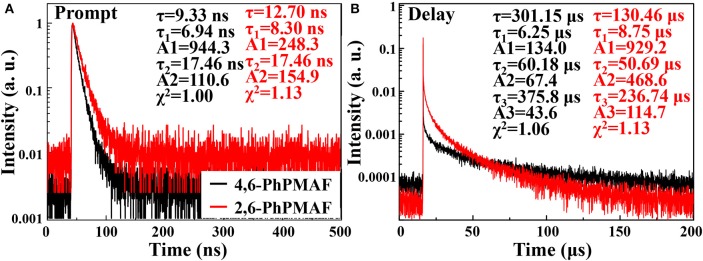
Transient photoluminescence characteristics of (A) prompt and (B) delay of 4,6-PhPMAF and 2,6-PhPMAF dopants in degassed CH2Cl2 solution and 22 wt%-doped in DPEPO (λex = 374 nm).